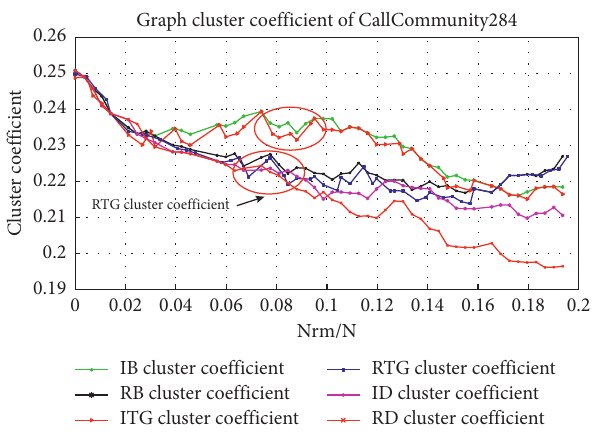
Figure 6: C G �( V,E ) result of CallCommunity.